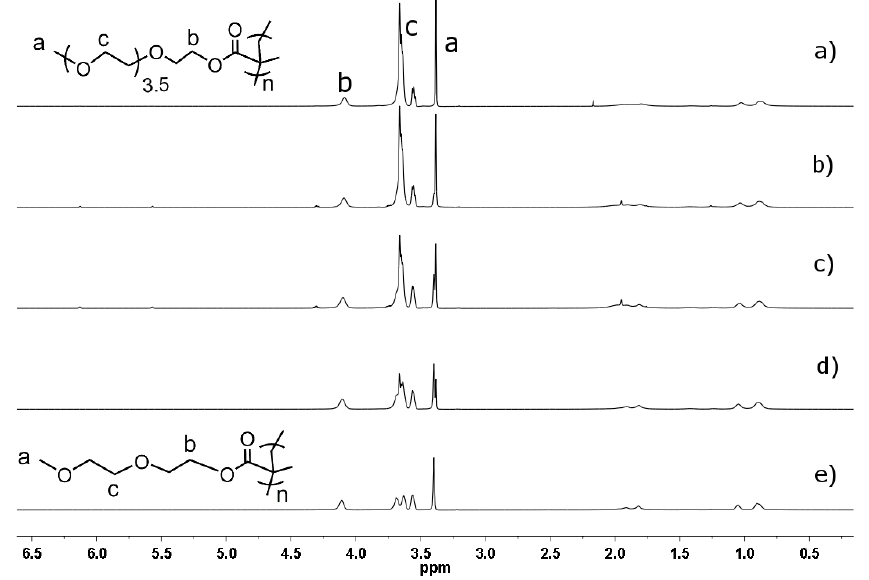
Figure 6. Hydrogen nuclear magnetic resonance ( 1 H-NMR) ( a ) POEGMA); ( b ) poly(OEGMA- co -DEGMA) 80:20 mole ratio feed; ( c ) poly(OEGMA- co -DEGMA) 50:50 mole ratio feed; ( d ) poly(OEGMA- co -DEGMA) 25:75 mol ratio feed; and ( e ) PDEGMA.